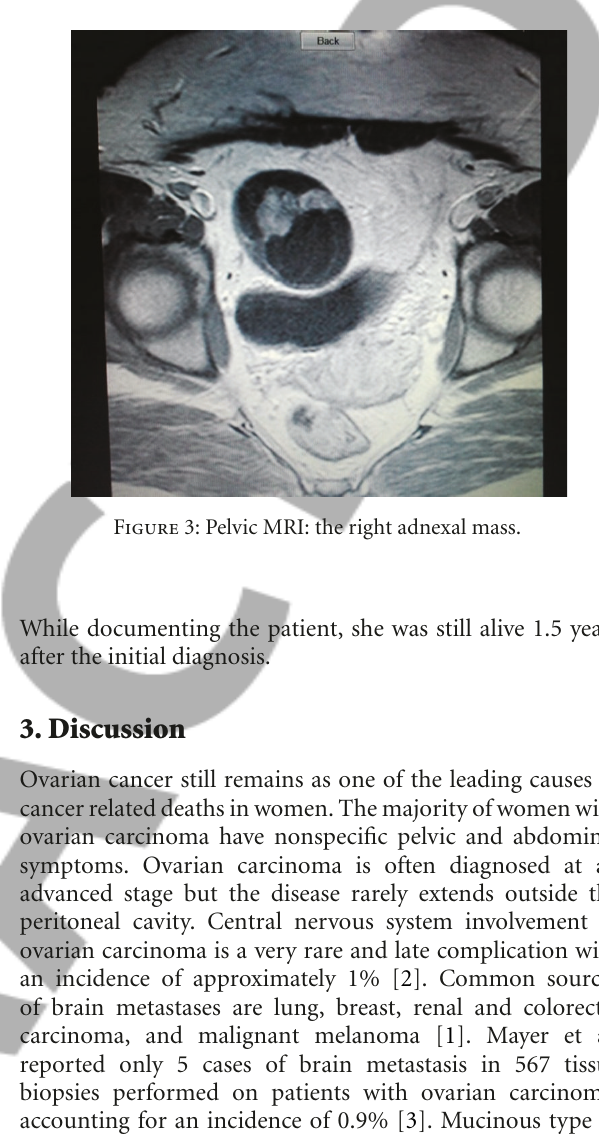
Figure 2: Cranial CT: left occipital cortical lesion.